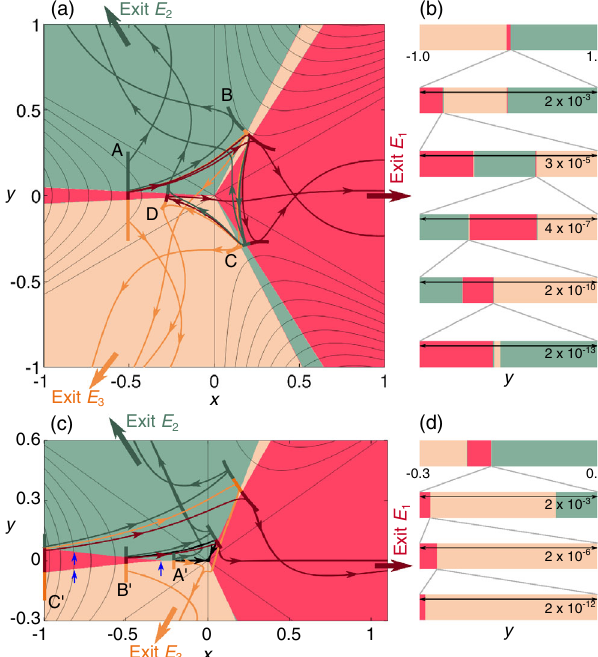
FIG. 1. Geometry and dynamics in the scattering region of undriven dissipative systems. (a) Fractal basin boundaries in the two-dimensional cross section _ x ¼ _ y ¼ 0 for potential U 2 ð r; θ Þ and μ ¼ 0 . 2 . The basins of the exits E 1 , E 2 , and E 3 are colored red, green, and beige, respectively. Trajectories starting on the one-dimensional cross section at x ¼ − 0 . 5 (vertical line segment A) are shown with arrows indicating the direction of flow and colors indicating the basin to which they belong. (b) Successive magnifications of the one-dimensional cross section at x ¼ − 0 . 5 in (a), showing the fractal nature of the basin boundaries. r; θ Þ and μ ¼ 1 . Trajectories with initial conditions on the 3 ð cross sections at x ¼ − 0 . 2 (segment A 0 ), x ¼ − 0 . 5 (segment B 0 ), and x ¼ − 1 (segment C 0 ) are shown. (d) Successive magnifica- tions of the cross section at x ¼ − 1 in (c), revealing a simple